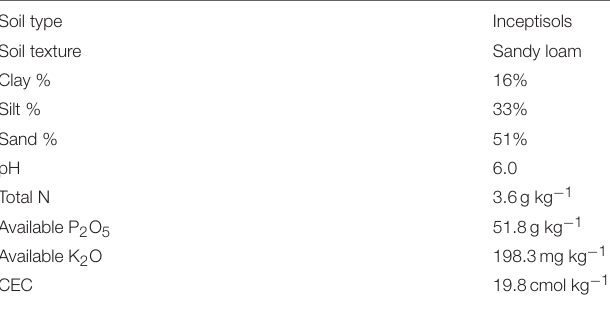
TABLE 1 | Soil properties of Fuchu Honmachi field (Tanaka et al.,